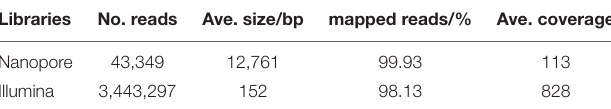
TABLE 1 | Summary of clean DNA sequencing data.